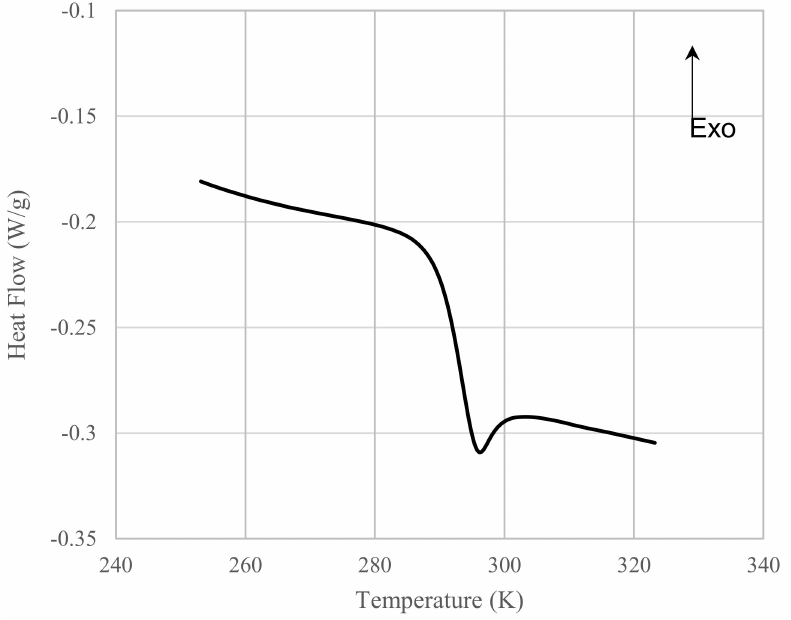
Figure 2. DSC charts of DNDM monomer